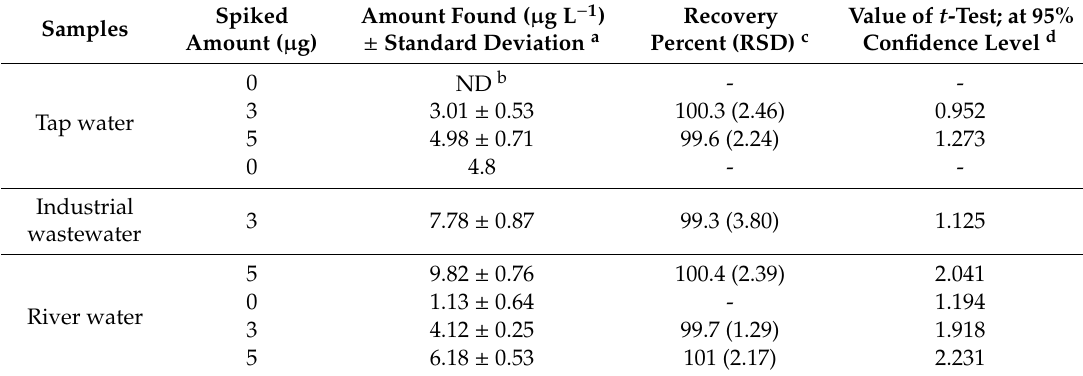
Table 4. ICP-OES determination of Hg(II) concentration in real samples after preconcentration and solid-phase